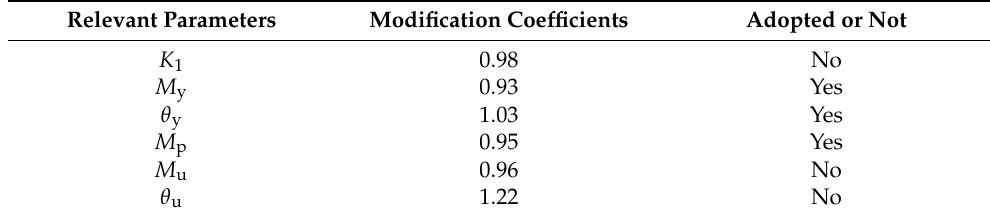
Table 2. Modification coefficients from